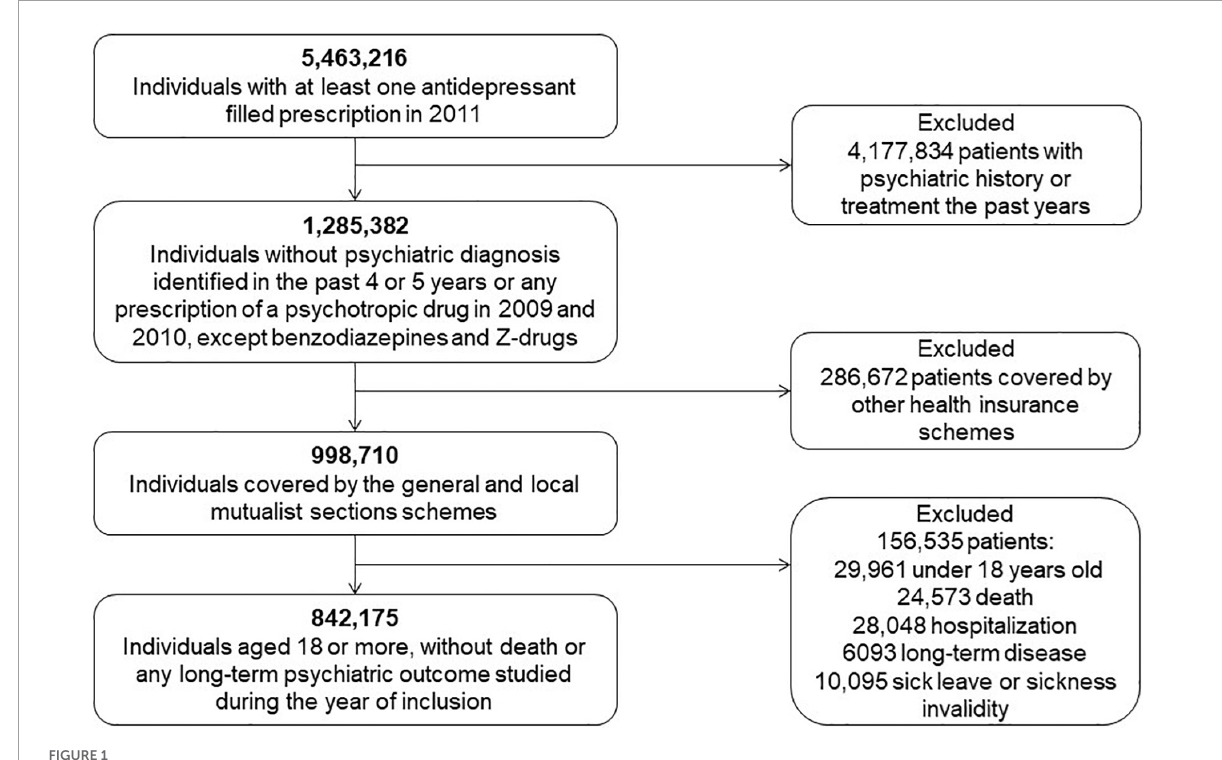
FIGURE1 Flow chart of the study population